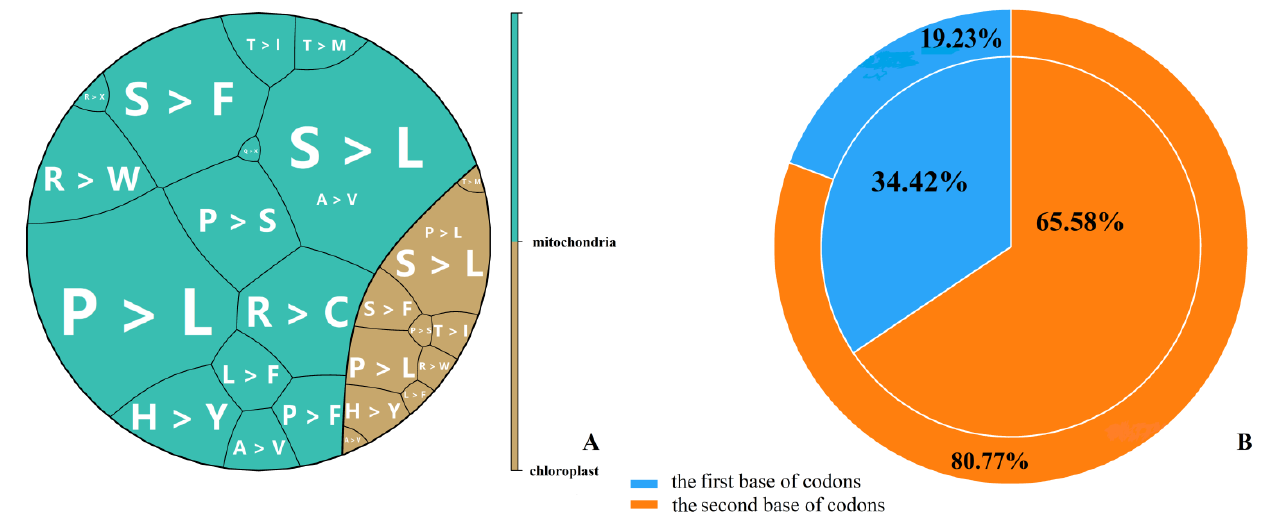
Figure 1. RNA editing sites predicted by PREP suite in tea chloroplast and mitochondria. ( A ) Amino acid residue substitutions resulting from RNA editing; the letters are the abbreviations for amino acid residues, and the block size represents the number of RNA editing sites. ( B ) Position of RNA editing sites in codons. The outer pie charts represent chloroplasts, and the inner pie charts represent mitochondria.